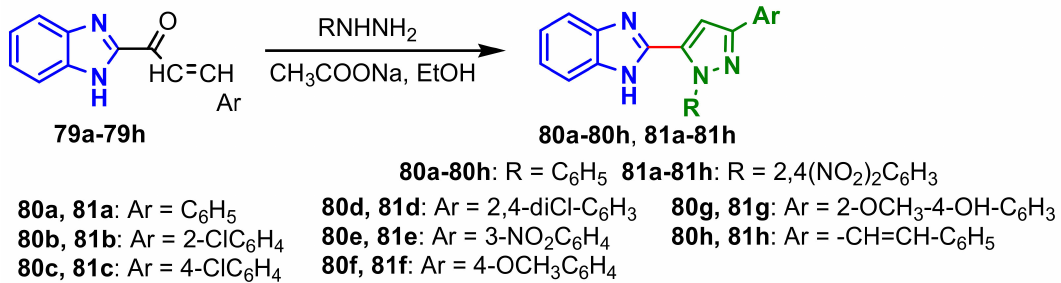
Table 8. The antimicrobial activity of the compounds 80a – 80h and 81a – 81h . Compounds